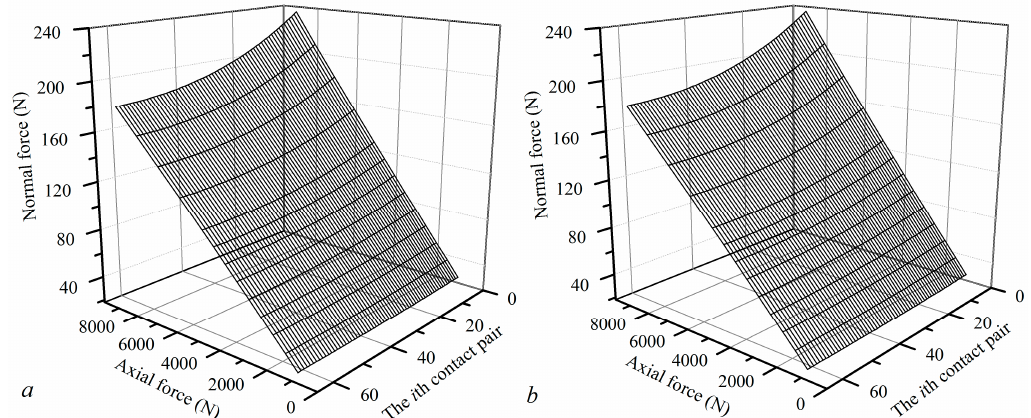
Figure 11. Variation of the dynamic contact force with the contact position and the axial force. ( a ) Dynamic contact normal force of screw. ( b ) Dynamic contact normal force of the nut.